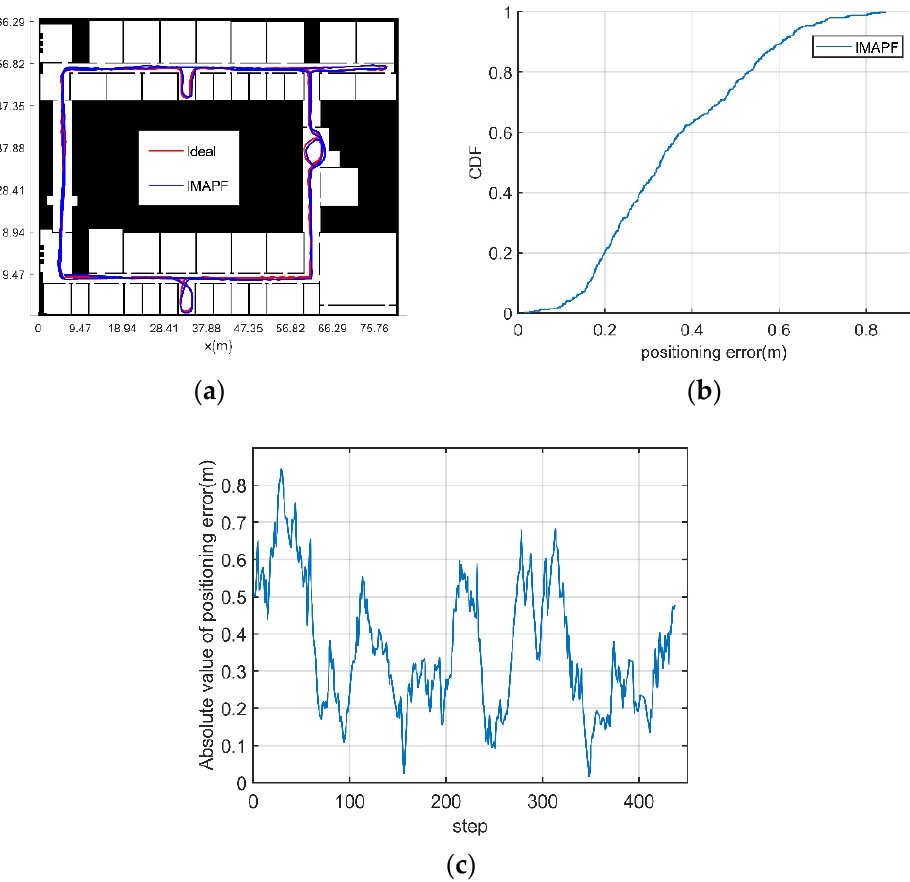
Figure 10. Navigation trace comparison and positioning error CDF curve with unknown initial position and heading. ( a ) Comparison diagram of positioning trace; ( b ) CDF curve of positioning error; and ( c ) absolute position error of each step.